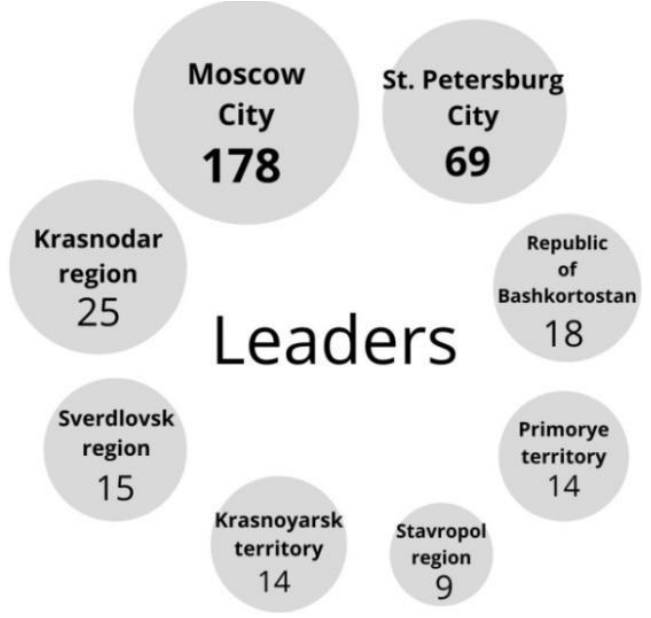
Figure 4. Leading regions in terms of the number of petitions having federal significance posted by their residents (the leader from each federal district is marked) (number of initiatives and peti- tions).